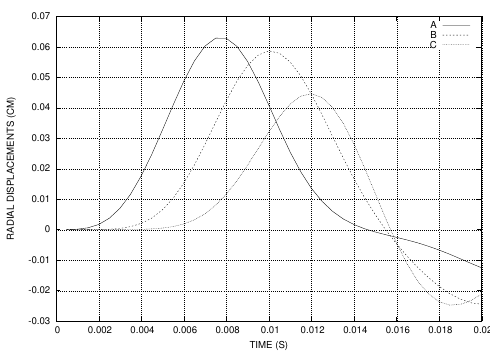
Figure 3. The time history of the displacement of three points on the interface using sin-like stress at the inlet.